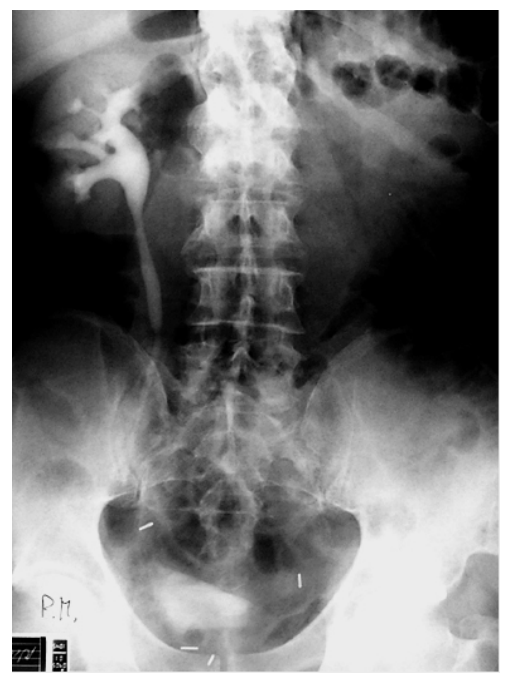
FIGURE 3. Urography after 60